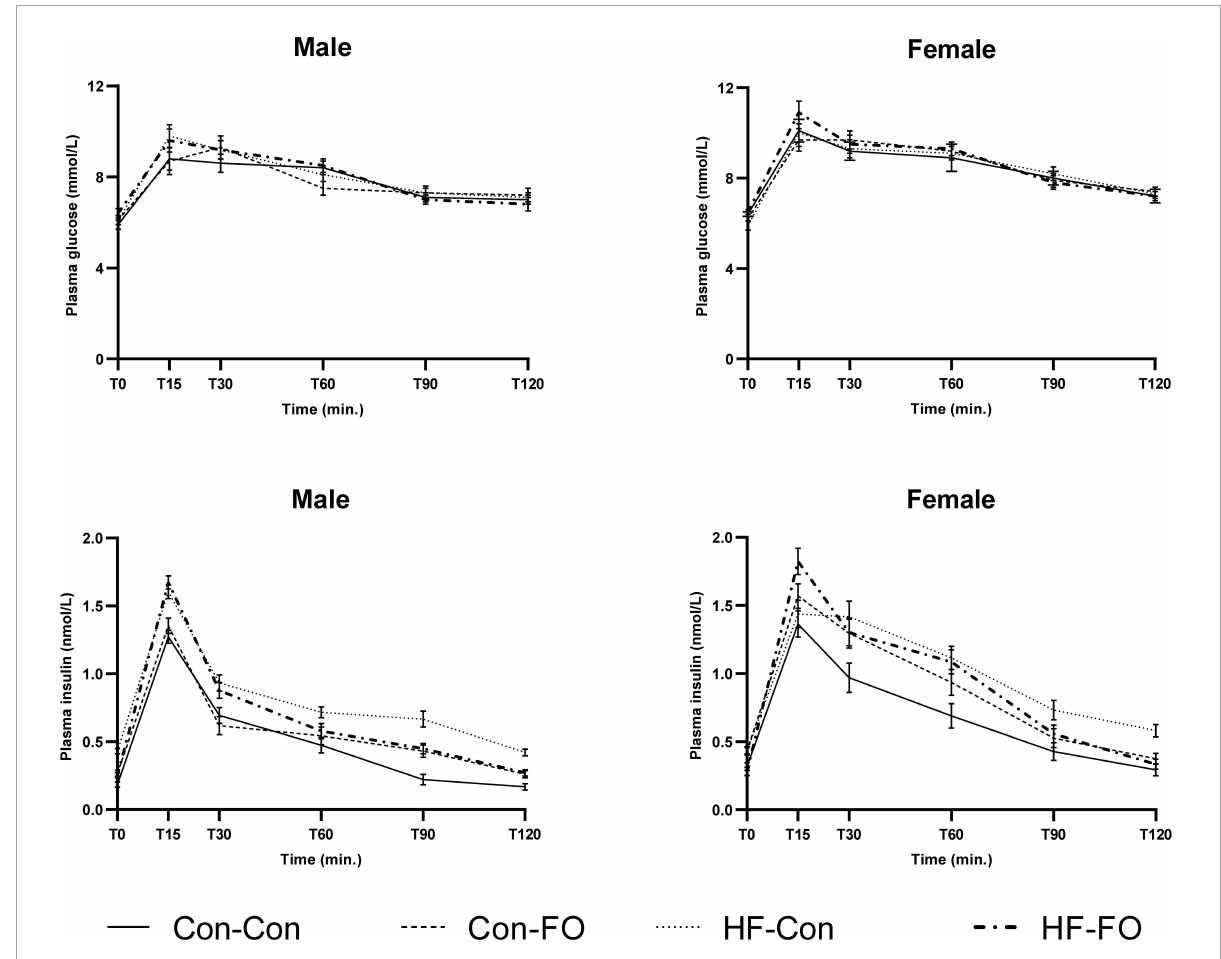
FIGURE4 Plasma glucose (above) and insulin (below) concentrations at each time point of the oral glucose tolerance test in male and female adult offspring (day 95). Error bars represent standard